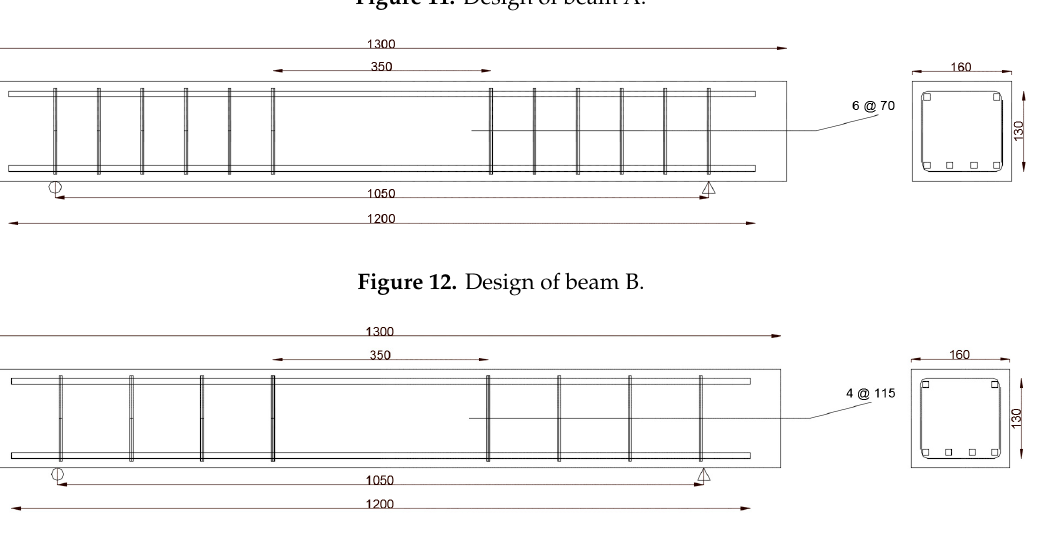
Figure 13. Design of beam C.